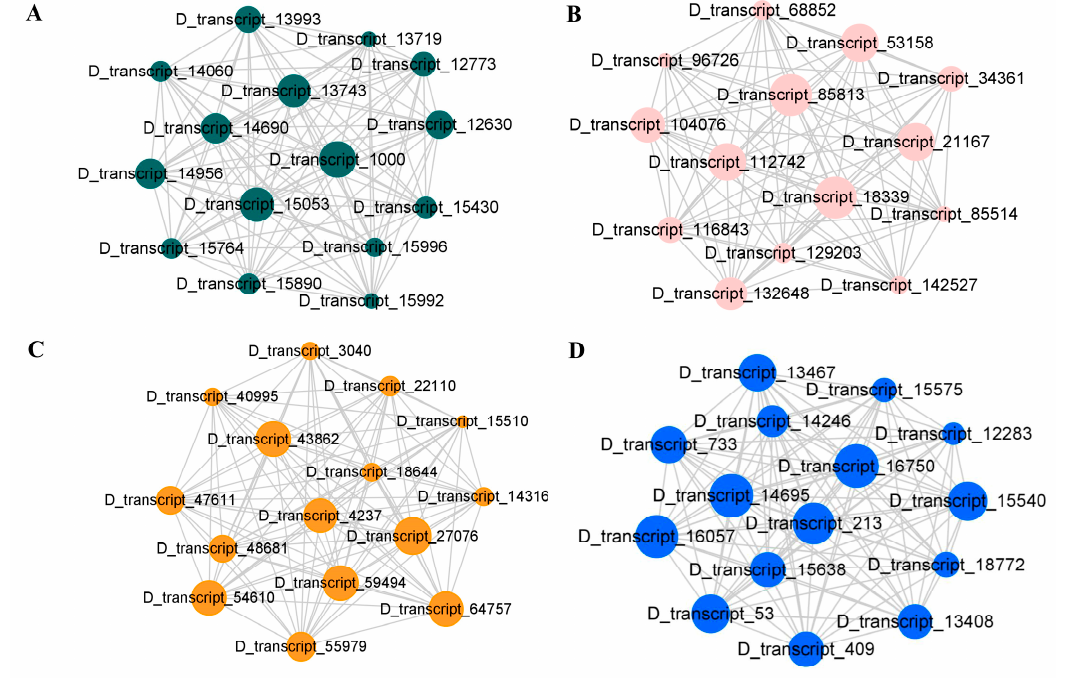
Figure 8. Hub genes in the candidate modules and their intramodular relationship. ( A ) Top 15 hub genes in turquoise, ( B ) top 15 hub genes in pink, ( C ) top 15 hub genes in black and ( D ) top 15 hub genes in blue.